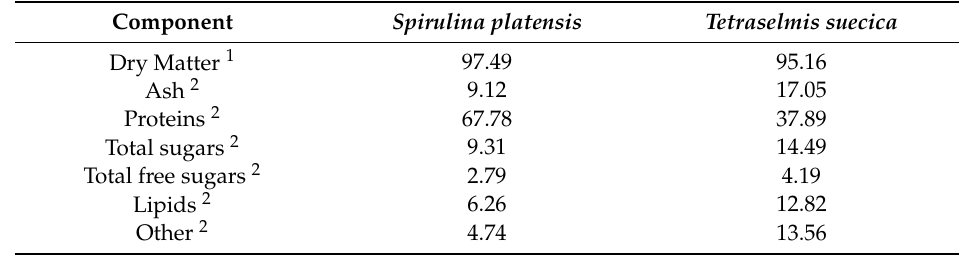
Table 2. Chemical composition of microalgal biomasses used in this work ( Spirulina platensis and Tetraselmis suecica